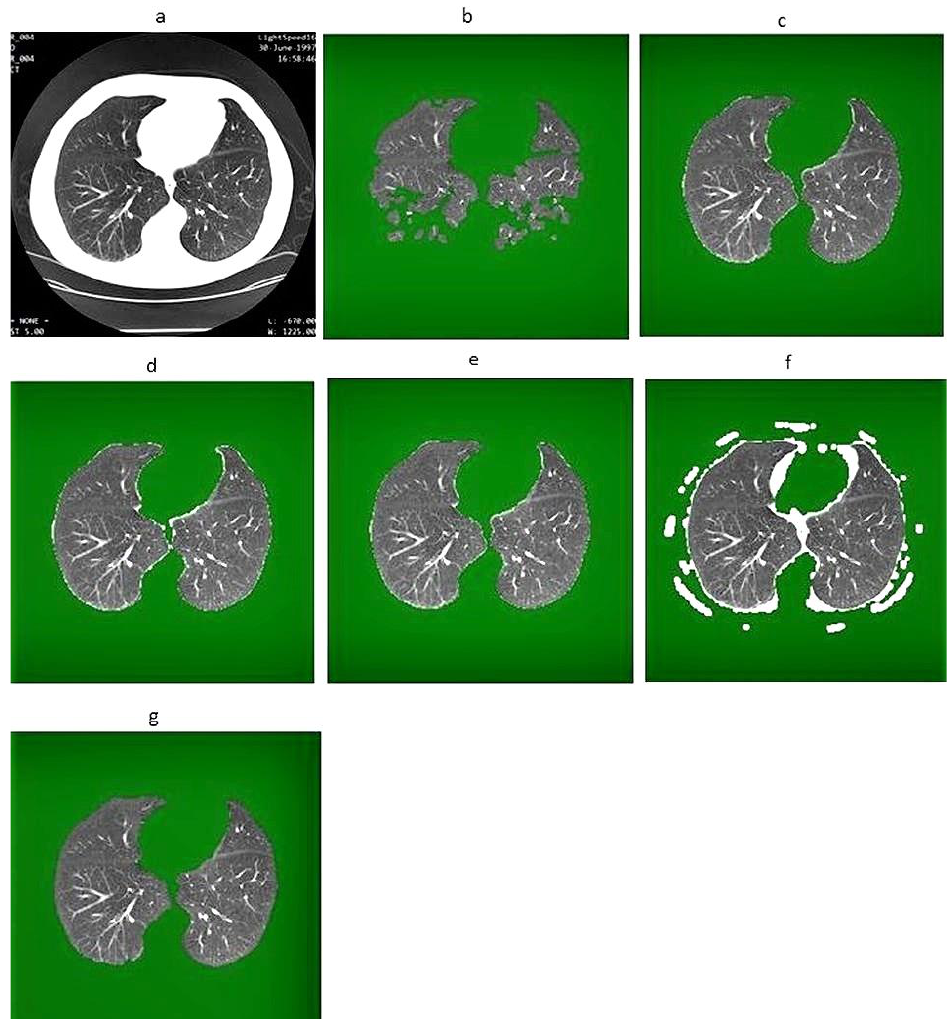
Figure 6. Result of the segmented image using the proposed method. ( a ) is the source image, and ( b – f ) are the segmented outputs with various global threshold values. ( g ) is the final segmented